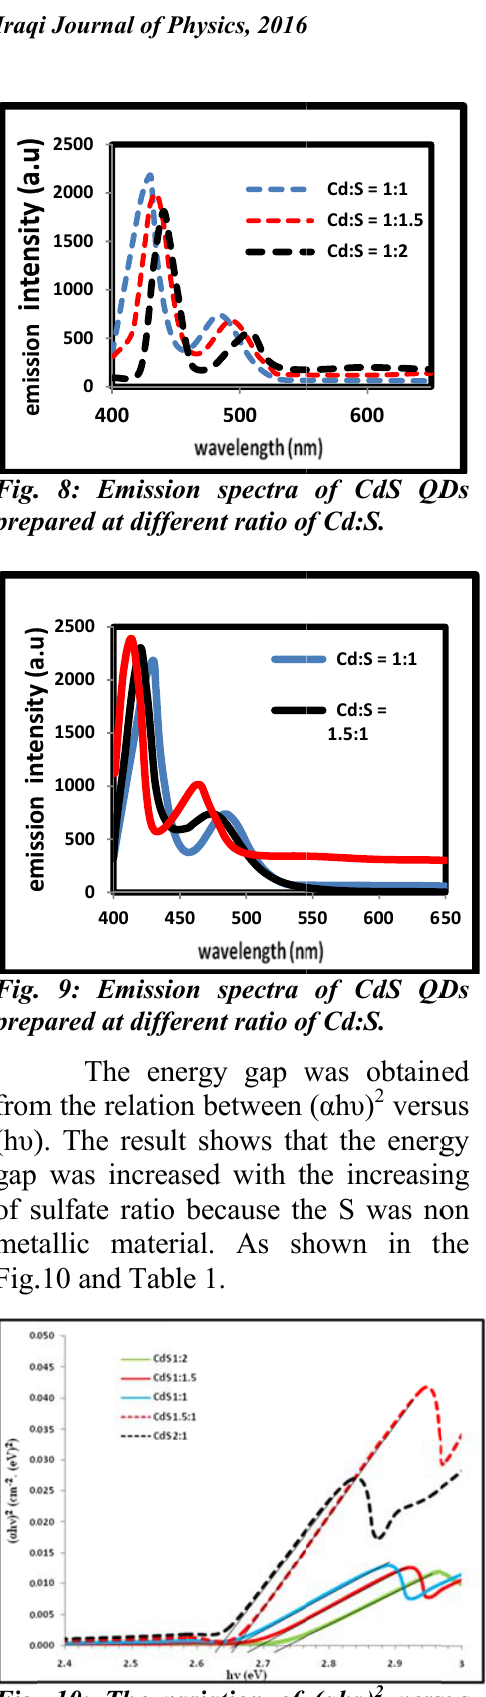
phot at d acid of